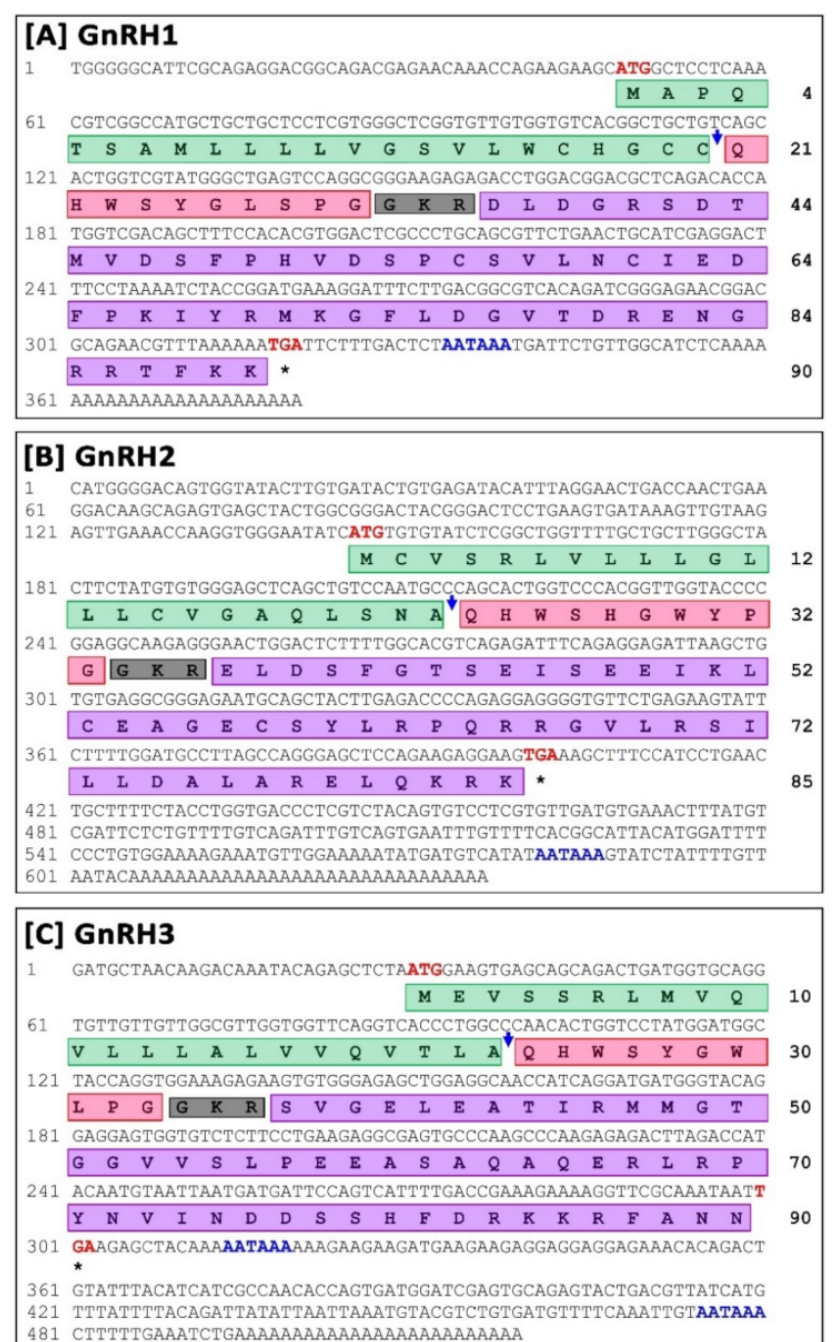
Figure 1. Full-length nucleotide and deduced amino acid sequences of small yellow croaker GnRH1 ( A ), GnRH2 ( B ), and GnRH3 ( C ). Numbers on the left and right side indicate nucleotide and amino acid positions in the sequences, respectively. Start and stop codons are marked in bold red. The stop codon is also indicated by an asterisk (*). Putative polyadenylations signals (AATAAA) are shown in bold blue. Putative signal peptides are boxed in green, GnRH decapeptide regions are highlighted in red box, cleavage sites are boxed in black, and GnRH-associated peptides are boxed in purple. GenBank nucleotide accession numbers and protein IDs are OK042349 and UFT26658.1 (syc-GnRH1), OK042350 and UFT26659.1 (syc-GnRH2), OK042351, and UFT26660.1